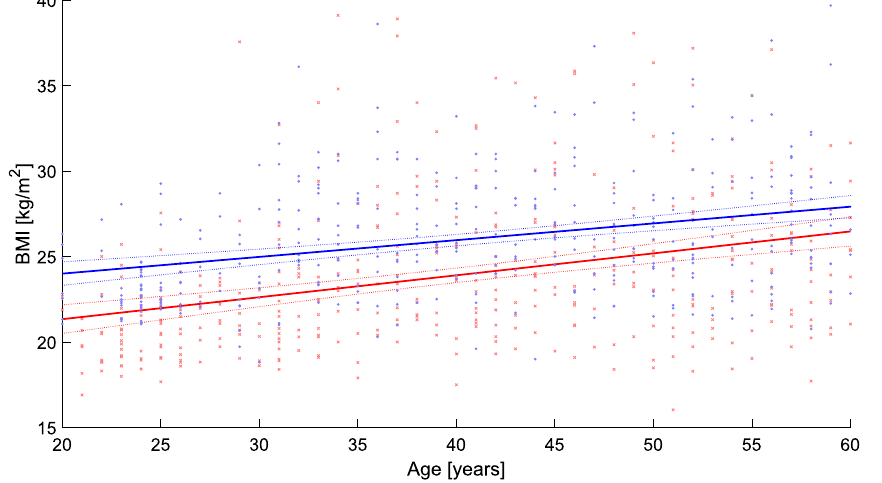
Figure 4. Relationship between the BMI and age.